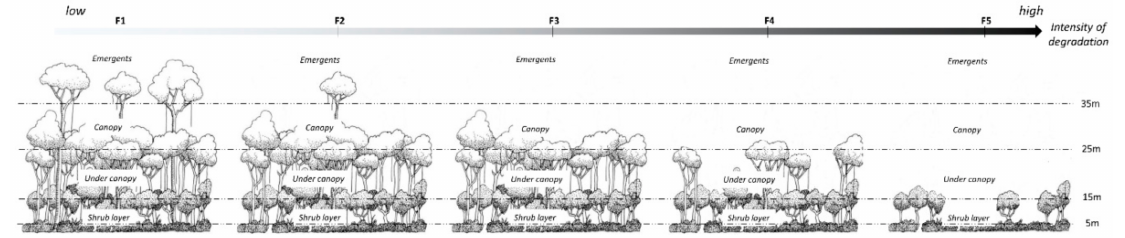
Figure 8. Five classes of degraded forest typology based on the observation of 140 forest sites in May 2015.